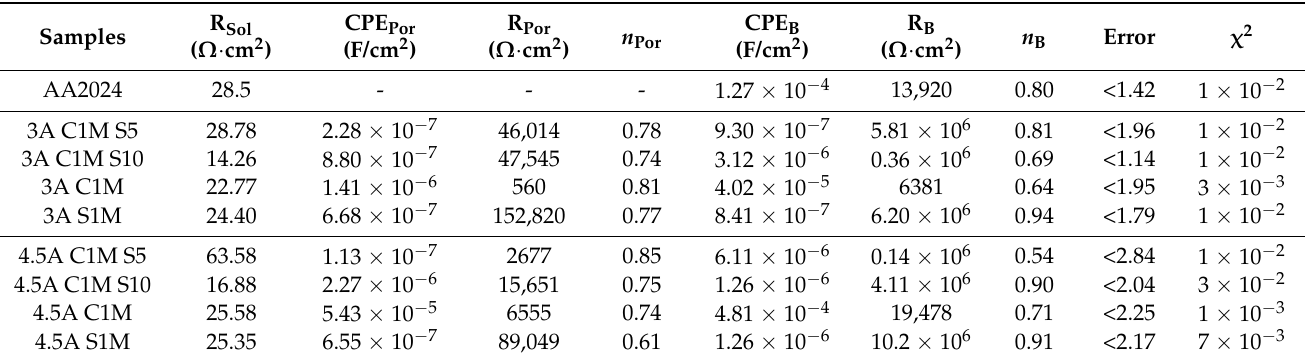
Table 3. Electrochemical parameters using EIS data obtained from the un-anodized AA2024 and anodized samples immersed in NaCl